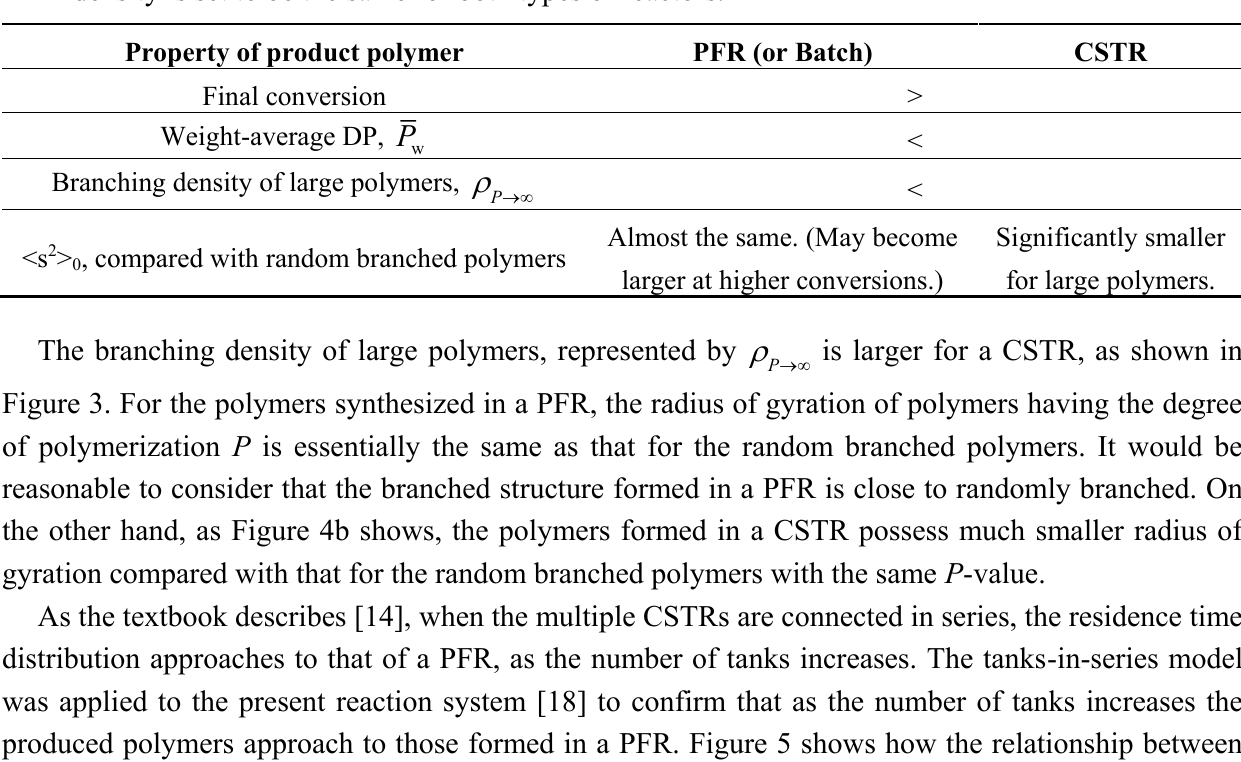
Table 1. Comparison of PFR and CSTR, under condition where the final average branching density is set to be the same for both types of